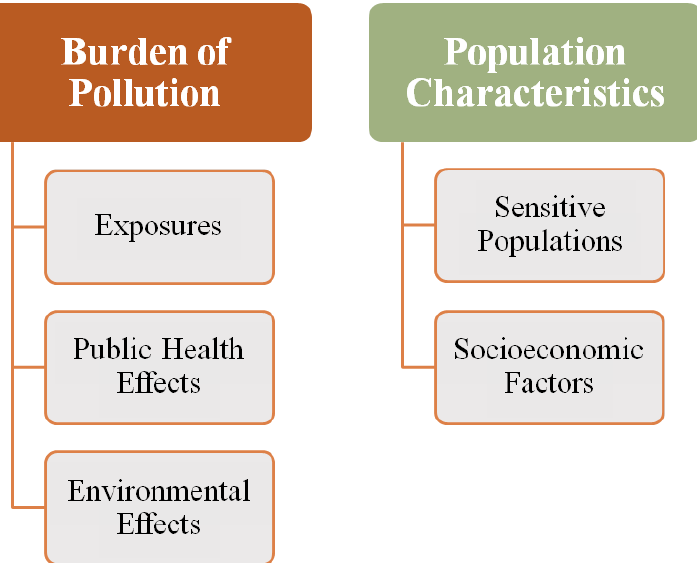
Figure 1. The five components of cumulative